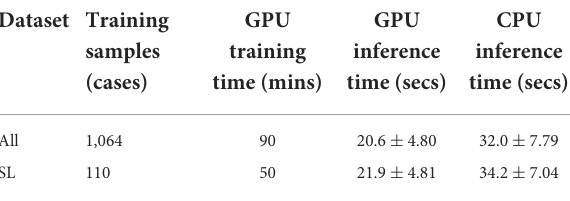
TABLE 2 Computational time comparison for the proposed DeepHeartCT frameworks using All and strong label (SL) dataset. Dataset